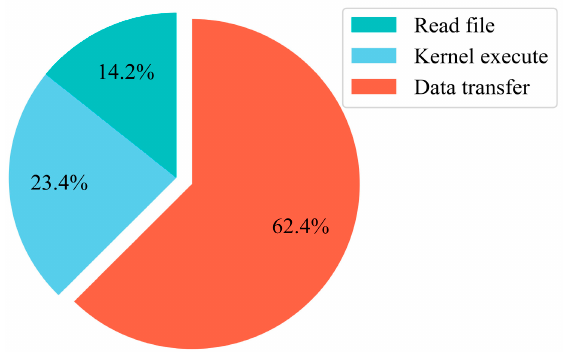
Figure 11. Description of the percentage of GPU runtime consumed by different GPU operations after using the fast math compiler option.